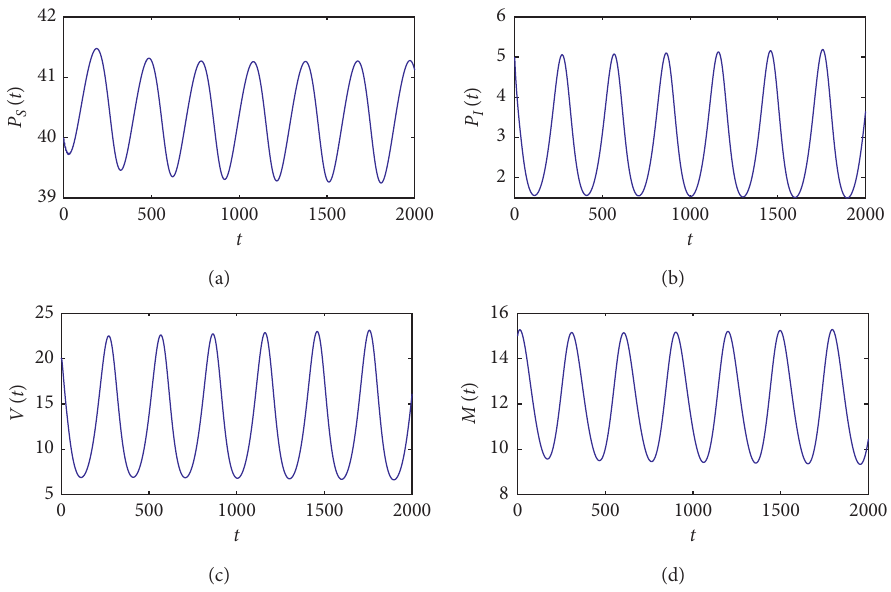
Figure 6: The time series of system (5) when α � 0.95 and τ � 33 > τ 0